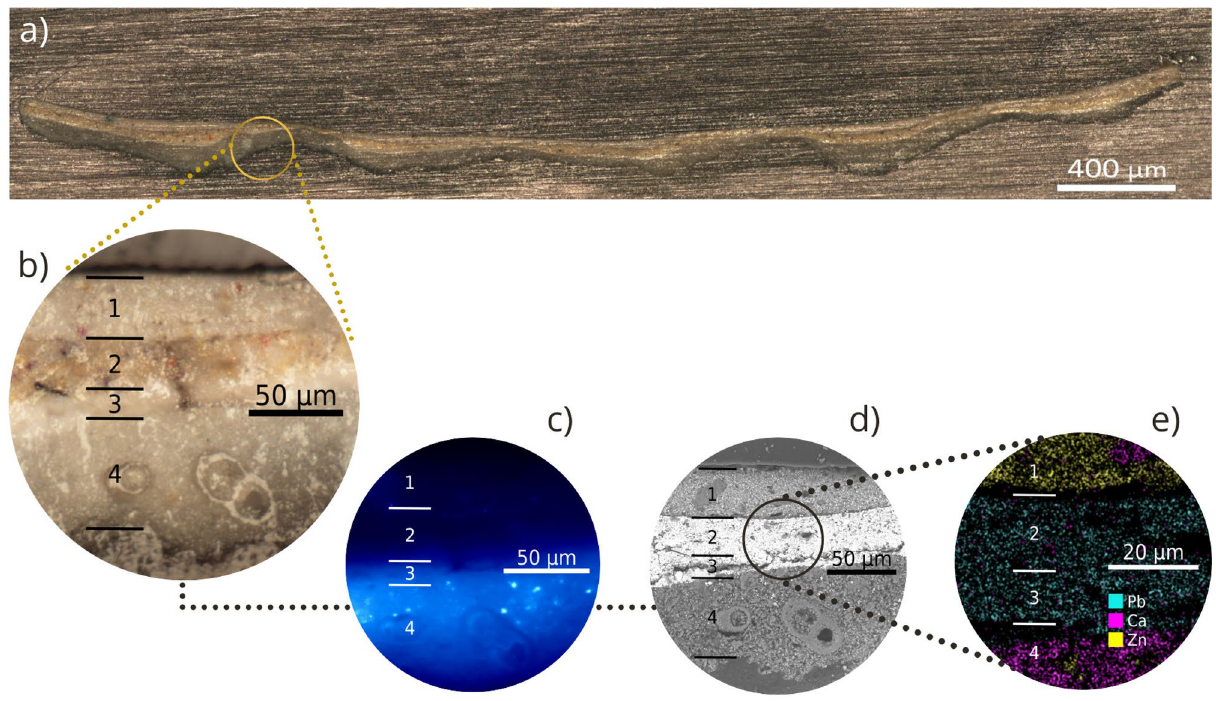
Figure 4. Through the lens: Stratigraphy of a 120-year-old large-format painting. ( a ) Panoramic Optical Microscopy (OM) image of the cross-sectioned sample M1-75W, observed by reflected visible light at 5X. ( b ) Detail of the sample observed by MO at 20X showing the main layers: (1) Top paint layer, (2) Intermediate paint layer, (3) Second ground layer, (4) First ground layer. ( c ) Fluorescence Microscopy showing fluorescent particles in layer 4. ( d ) Scanning Electron Microscopy (SEM) showing the area analyzed by SEM-EDX using the mapping tool. ( e ) The main elements in each